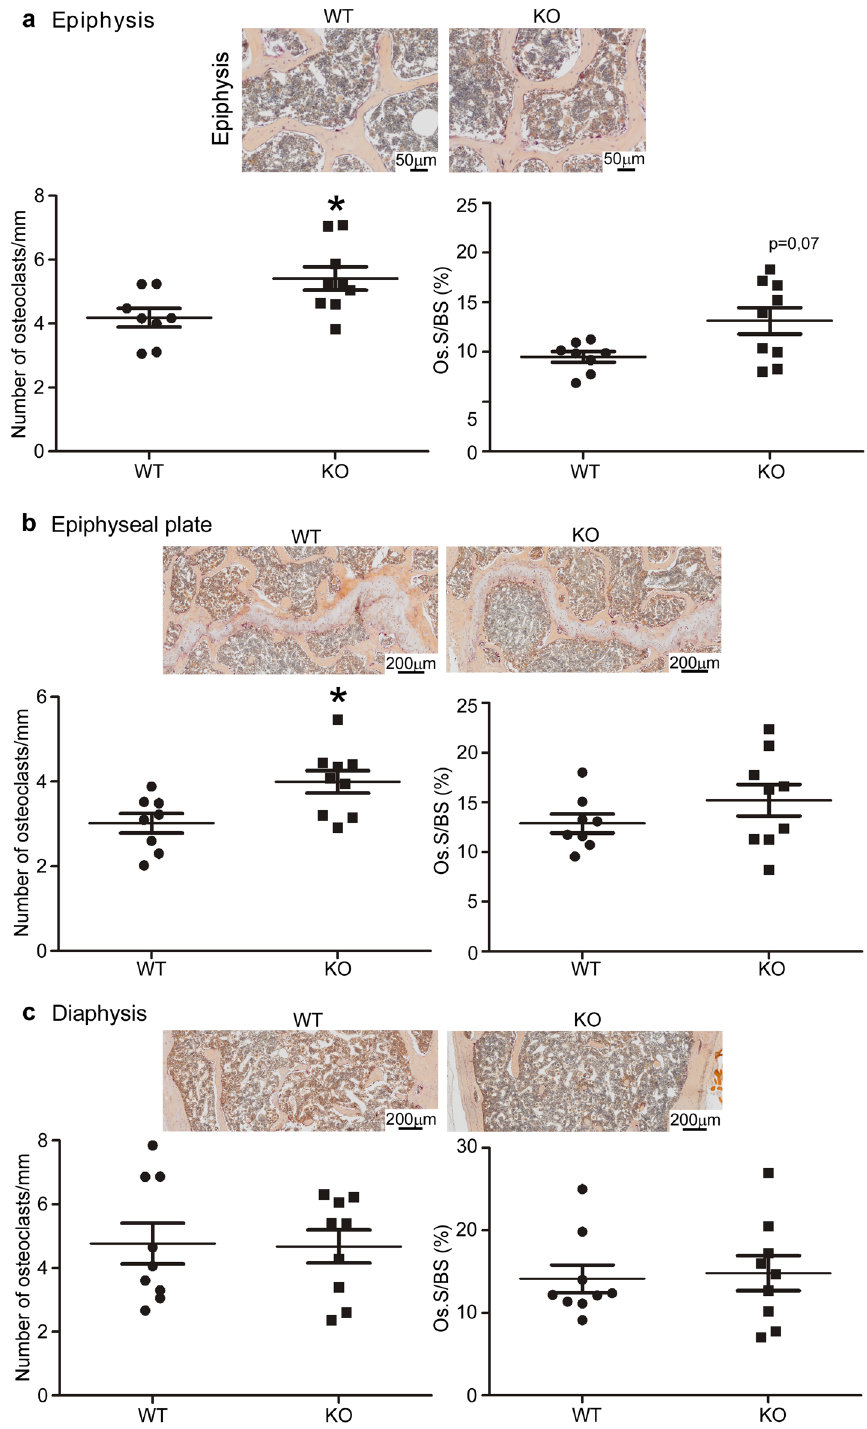
Figure 5. The number of osteoclasts is increased in the epiphysis and metaphysis of Hyal1 −/− femurs compared to WT femurs. ( a – c ) Representative histological sections of distal femurs from 18-month-old male Hyal1 −/− or WT mice stained for TRAP and counterstained with hemalun. The number of osteoclasts per mm, as well as Osteoclast Surface/Bone Surface (Os.S/BS in %) were calculated on 2 slices for each mouse (with n ≥ 8 for each group). The quantifications were conducted at 3 different positions in the femur: the epiphysis ( a ), the epiphyseal plate ( b ), and the diaphysis ( c ) (approximately at 25–30% distance from the distal end). The graphs represent the means ± SEM. *p < 0.05 (two-tailed Mann–Whitney U